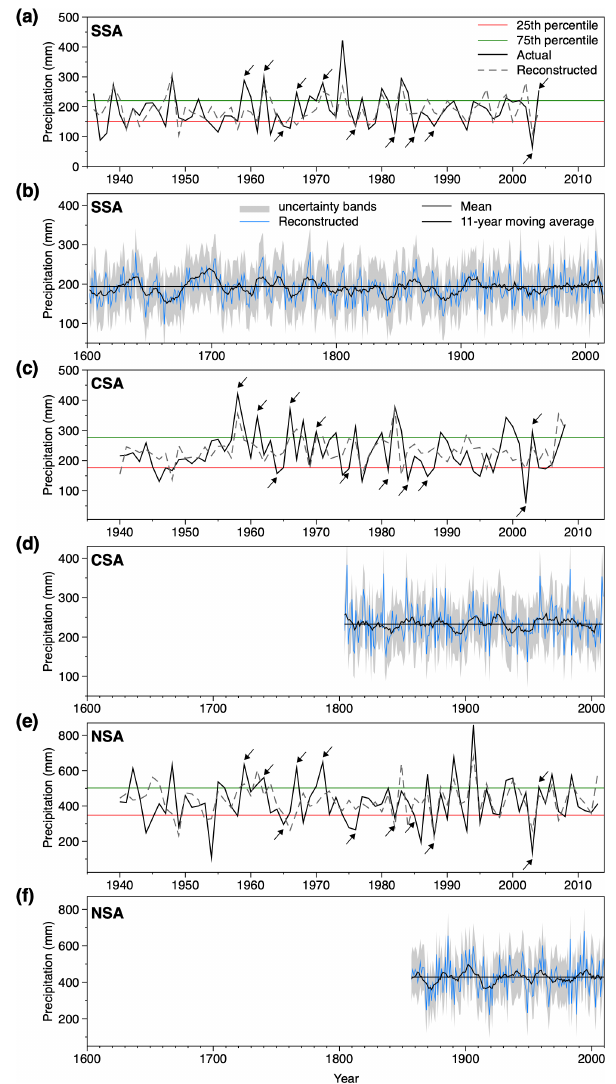
Figure 5. Actual and reconstructed precipitation for the SSA (a, b) , CSA (c, d) and NSA (e, f) . Uncertainty bands estimated as twice the standard error of prediction ( ± 2 σ ) (Wilks, 1995). Arrows indicate common extreme wet and dry years in instrumental data (values above 75th and below 25th percentiles of measurements, respec-